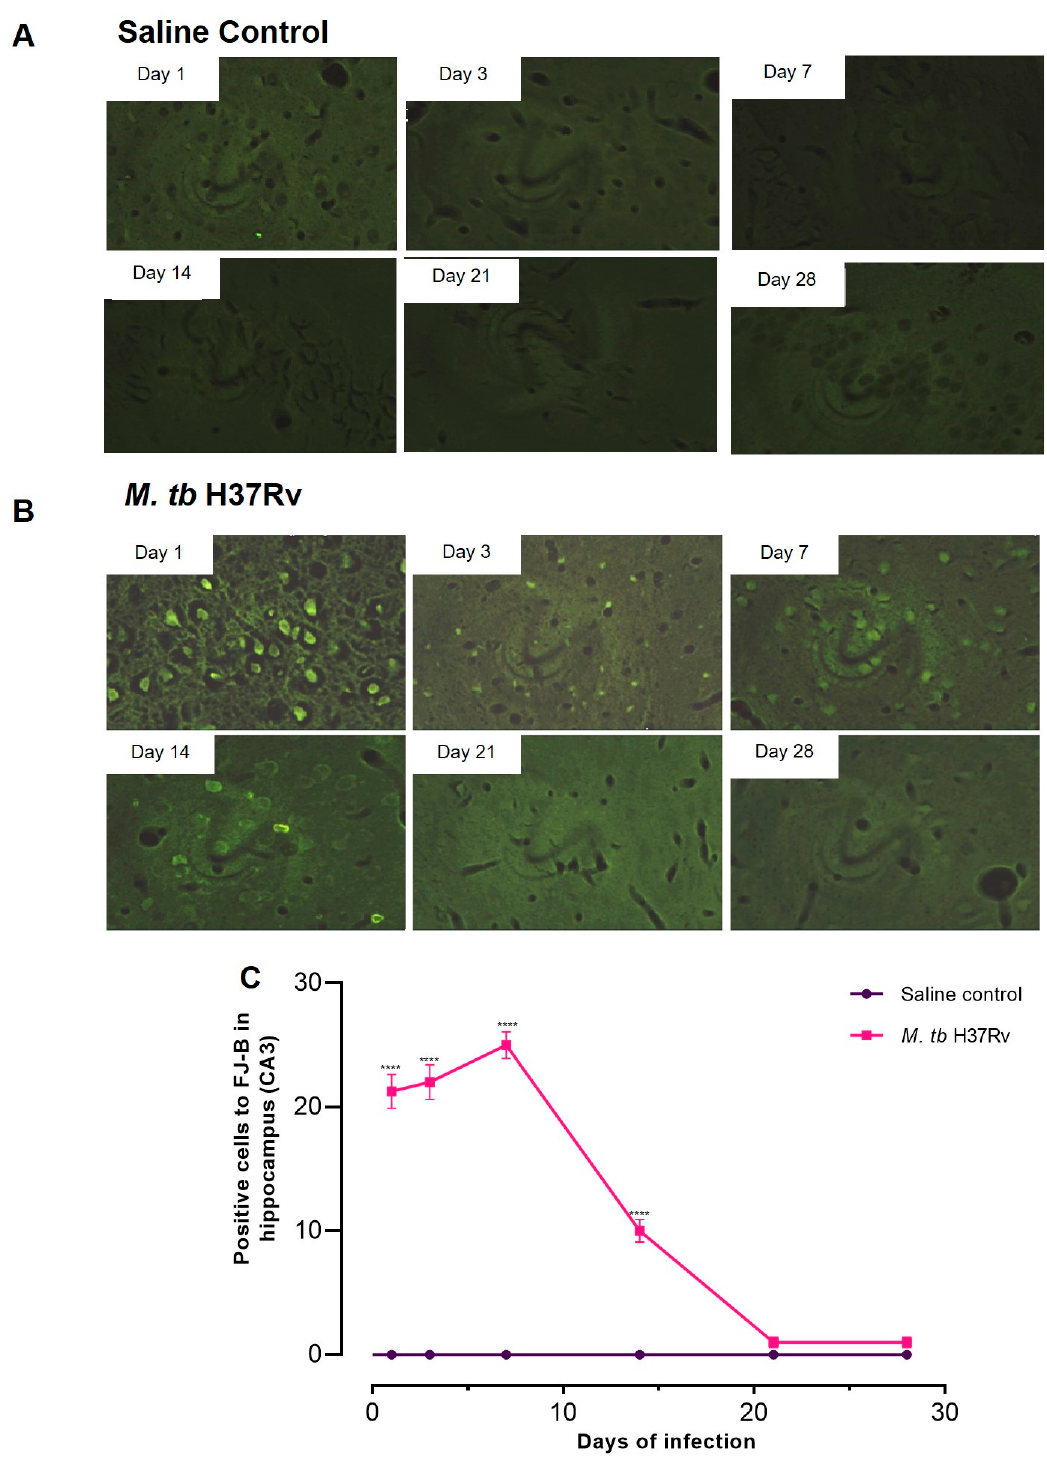
Figure 7. Pulmonary infection with M. tb induced neuronal injury in the hippocampus (CA3) at the early phase of infection. ( A ) Representative images of the Fluoro-Jade B (FJ-B) staining in CA3 in the saline control and tuberculous mice ( B ) at di ff erent time points after M. tb infection. ( C ) Quantification of positive cells to FJ-B in the hippocampus at the indicated days post-infection. Only infected pulmonary animals showed positive cells to FJ-B during the first and second week. Data are expressed as mean ± SEM. F (1, 6) = 2360, p < 0.0001, two-way ANOVA; **** p < 0.0001, Sidak’s multiple comparisons test ( α = 0.05) ( n =